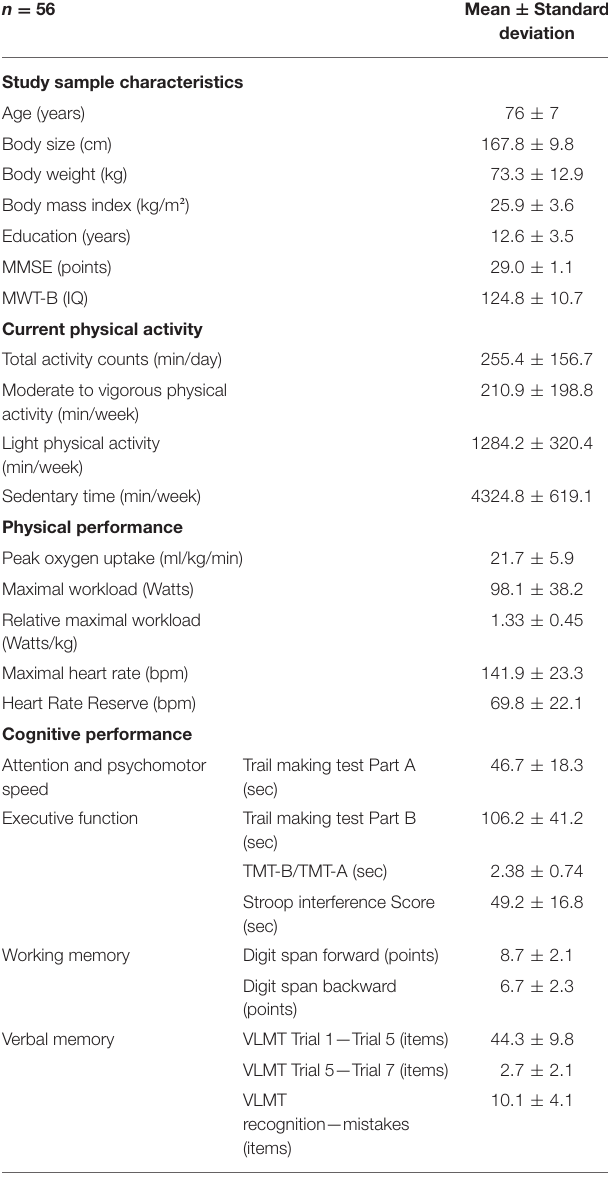
TABLE 1 | Descriptive data of study sample characteristics, current physical activity, physical performance, and cognitive performance. n = 56 Mean ± Standard